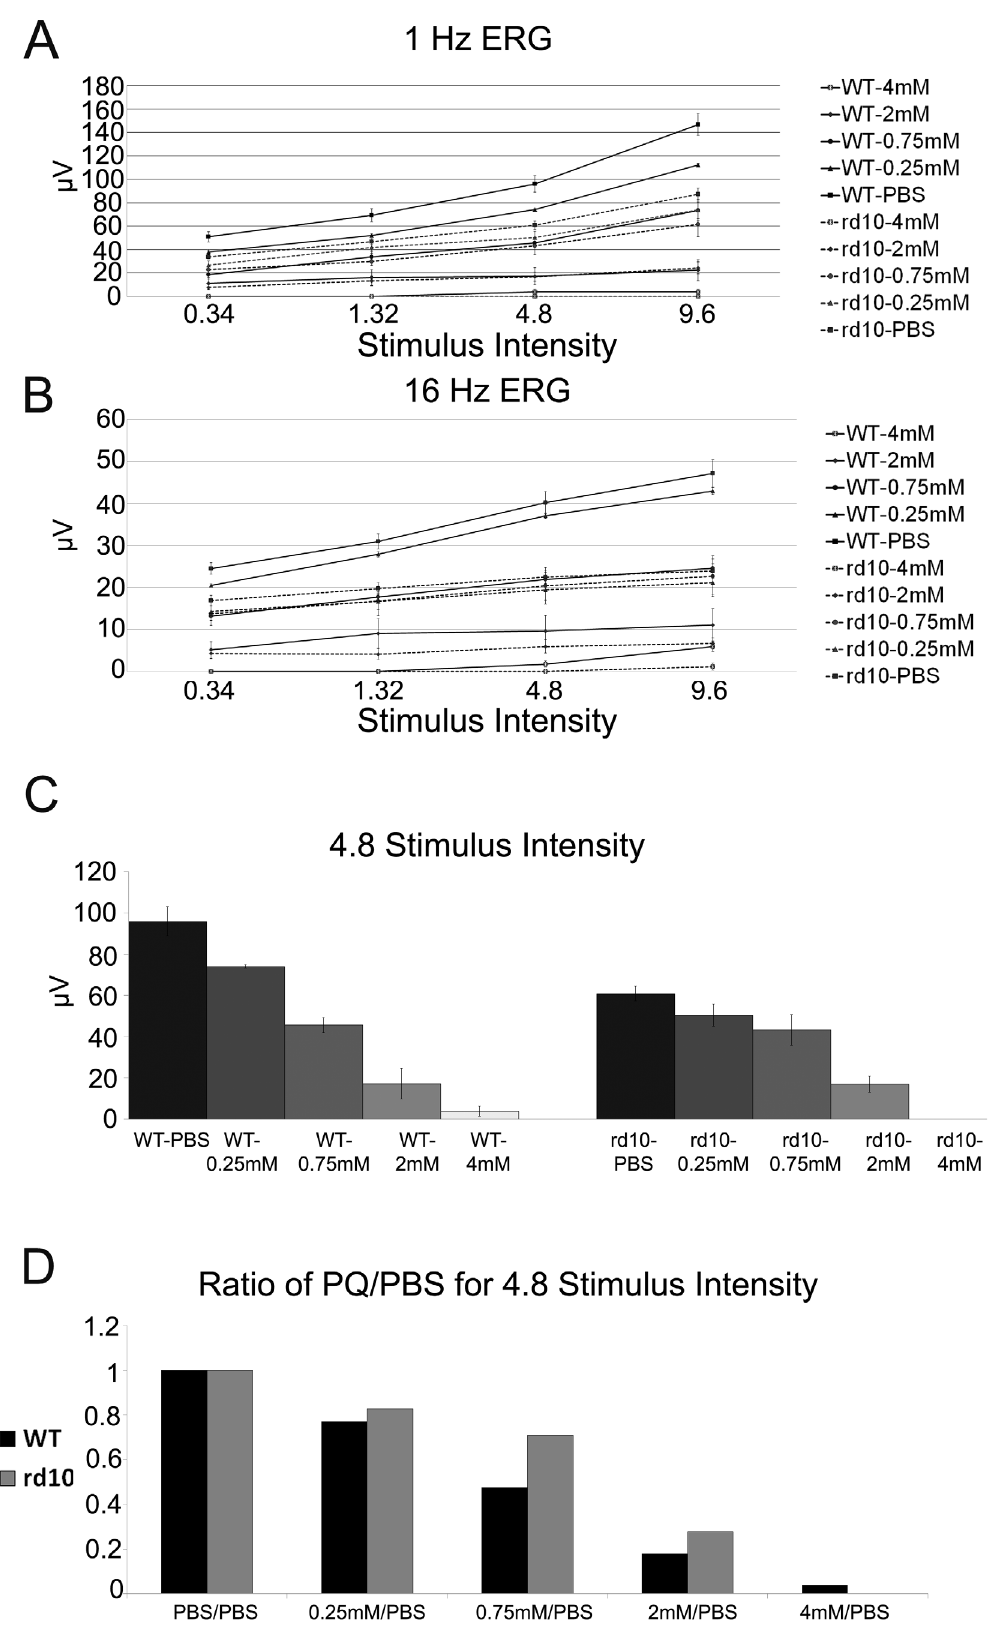
Figure 2. Photopic 1 Hz and 16 Hz ERG amplitudes in wild type (WT) and rd10 mice following PQ or PBS injection. (A) 1 Hz photopic amplitude shows both WT and rd10 mice after PQ or PBS injection. (B) indicates 16 Hz ERG amplitude for same WT and rd10 mice after PQ or PBS